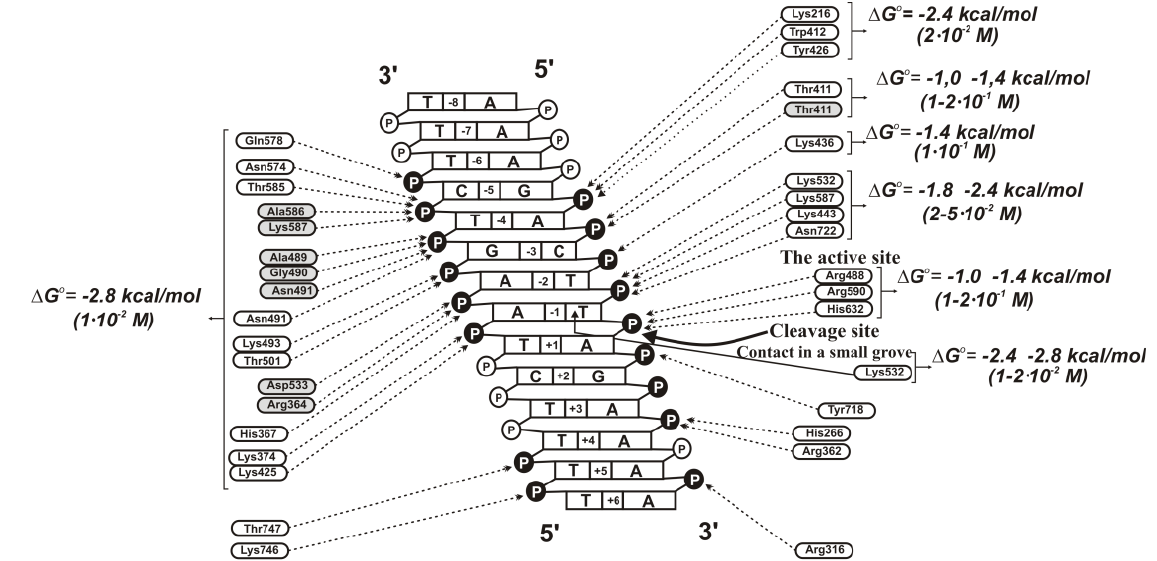
Figure 15. Schematic representation of the relative efficiency of different contacts formed by amino acid residues of human Topo I with internucleoside phosphate groups and the T-base of a specific sequence, revealed by X-ray analysis. The data on the right and left show approximate K d values and ∆G° estimated using the SILC method [11–13].